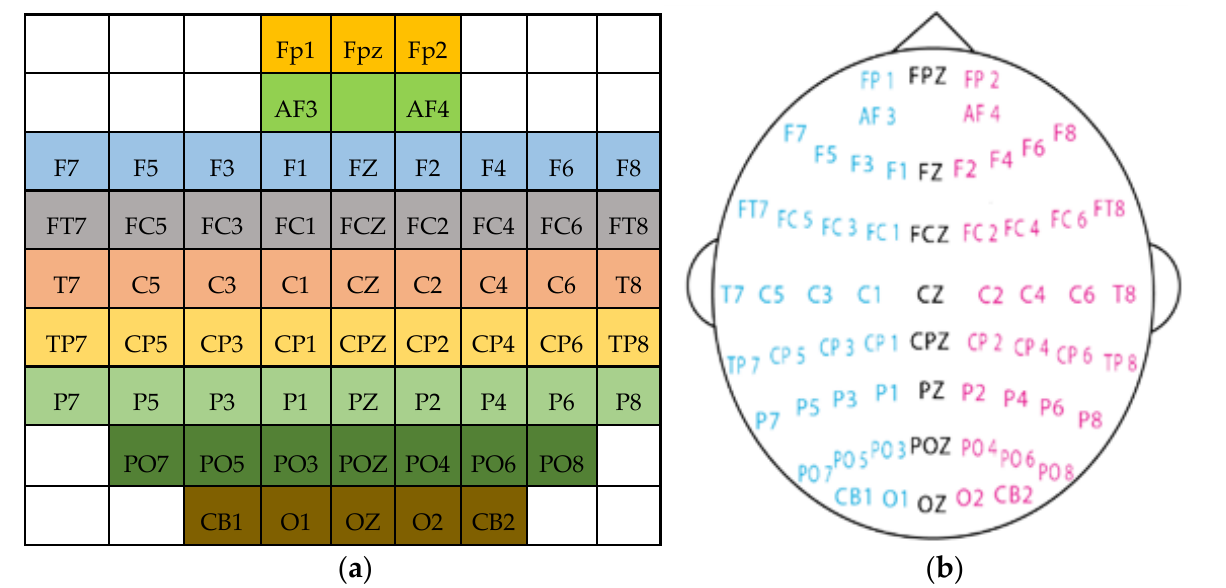
Figure 1. ( a ) EEG electrode arrangements on 2D 9 × 9 frame; ( b ) Electrode placement in SEED and SEED-IV datasets. Schemes follow another format [29–31].